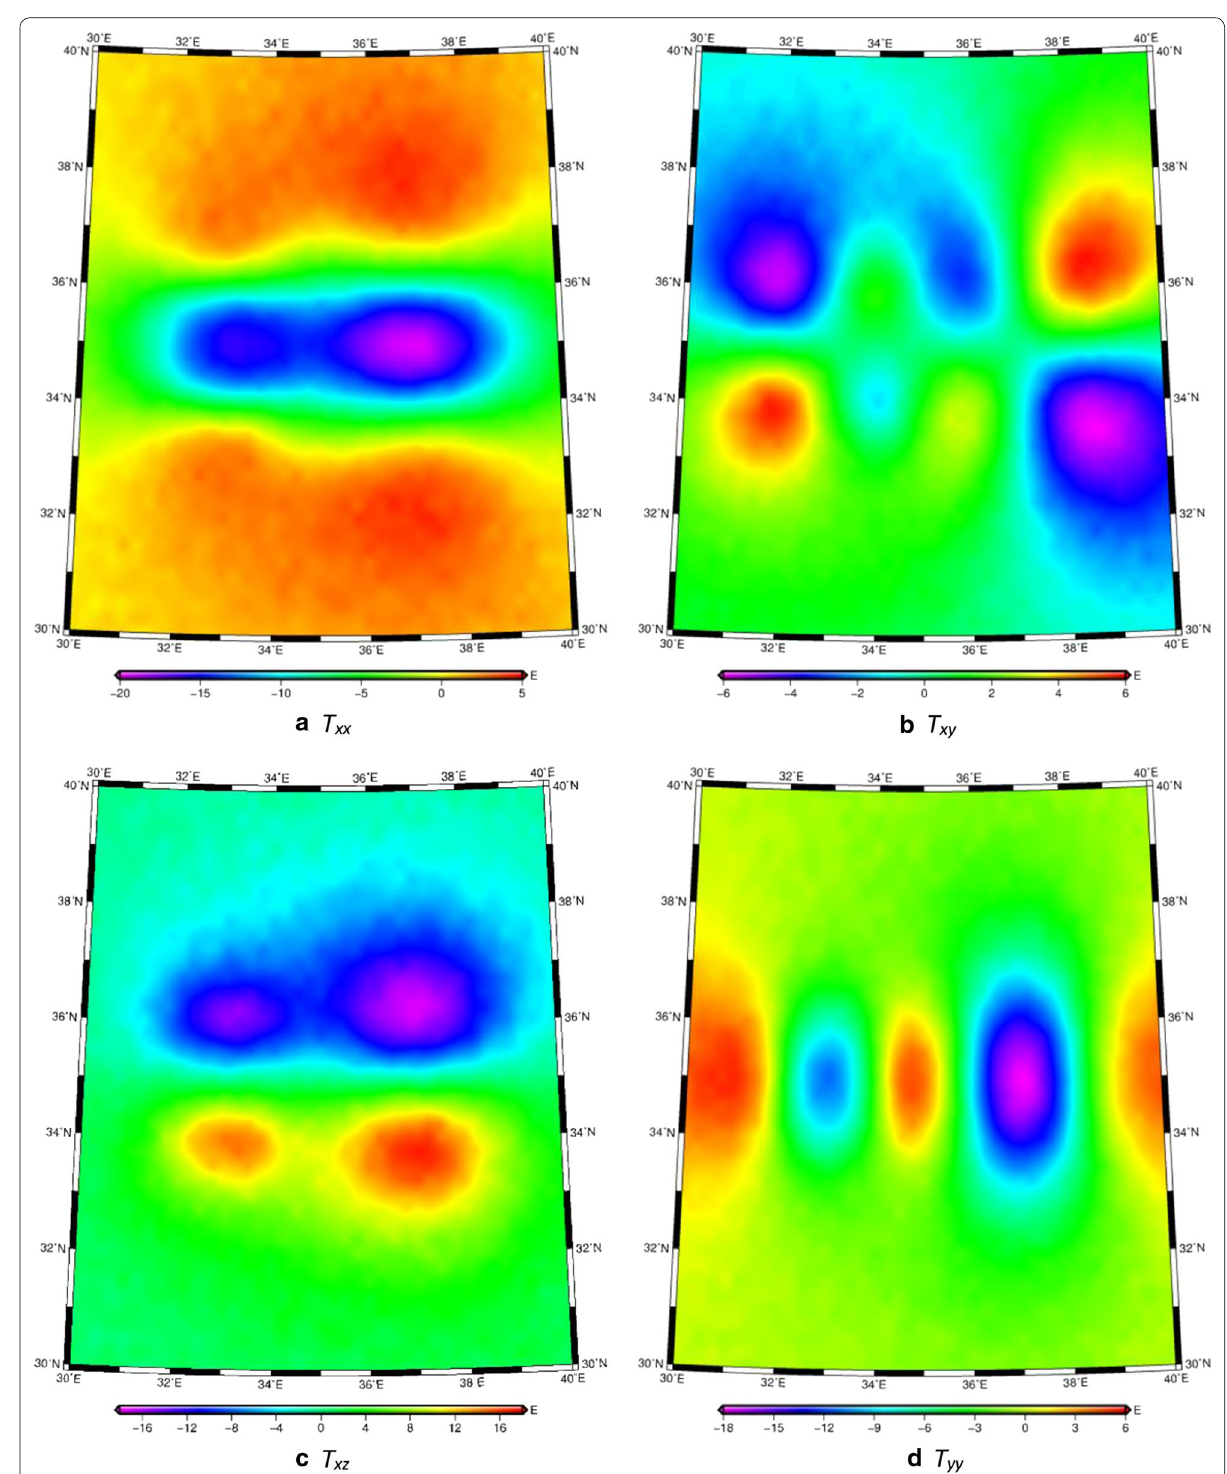
Fig. 11 Artificial theoretical datasets of the GGT with noise for composite models, a , b , c and d are T xx , T xy , T xz and T yy component of the GGT,